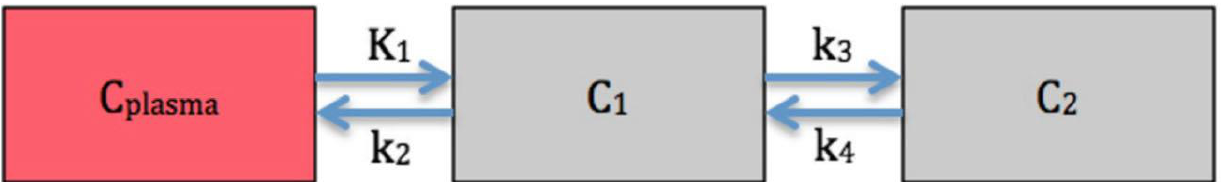
Figure 1. Schematic representation of the two-tissue compartment model applied for 18 F-FDG. K 1 , k 2 , k 3 and k 4 are rate constants (1/min) and describe the directional exchanges between the three compartments. C plasma represents the vascular compartment, C 1 represents the free and non-specifically bound tracer in tissue (non-displaceable compartment) and C 2 represents the specifically bound (phosphorylated) tracer in tissue. K 1 reflects the carrier-mediated transport of 18 F-FDG from plasma to tissue and k 2 reflects the transport of the radiopharmaceutical back from tissue to plasma, while k 3 represents the phosphorylation rate and k 4 the dephosphorylation rate of the glucose analogue. Baseline PET/CT at SMM diagnosis revealed no pathological findings suggestive of myeloma. Merely, a discretely increased, diffuse tracer uptake in the bone marrow was